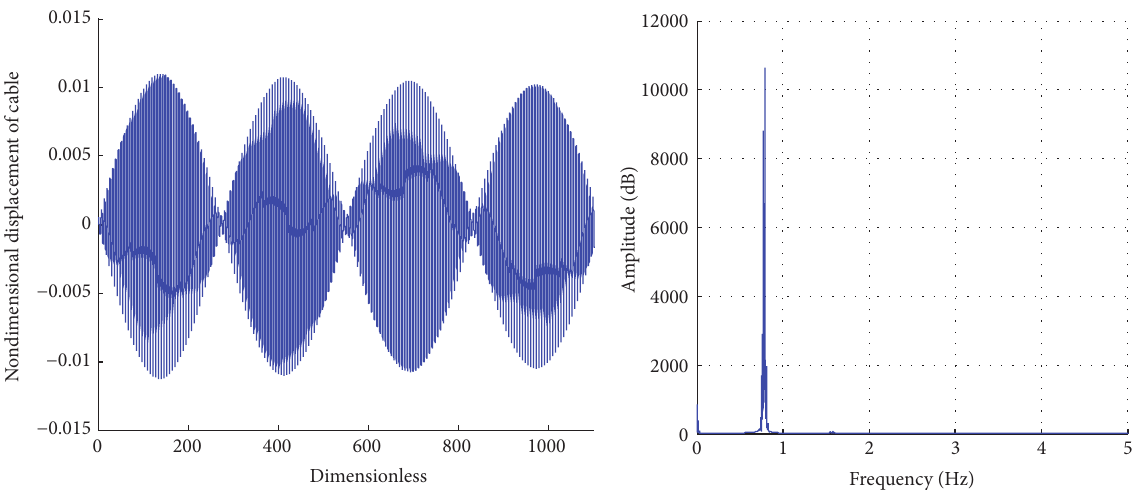
Figure 2: Dimensionless displacement response time history and amplitude-frequency characteristic curve of the cable midspan.